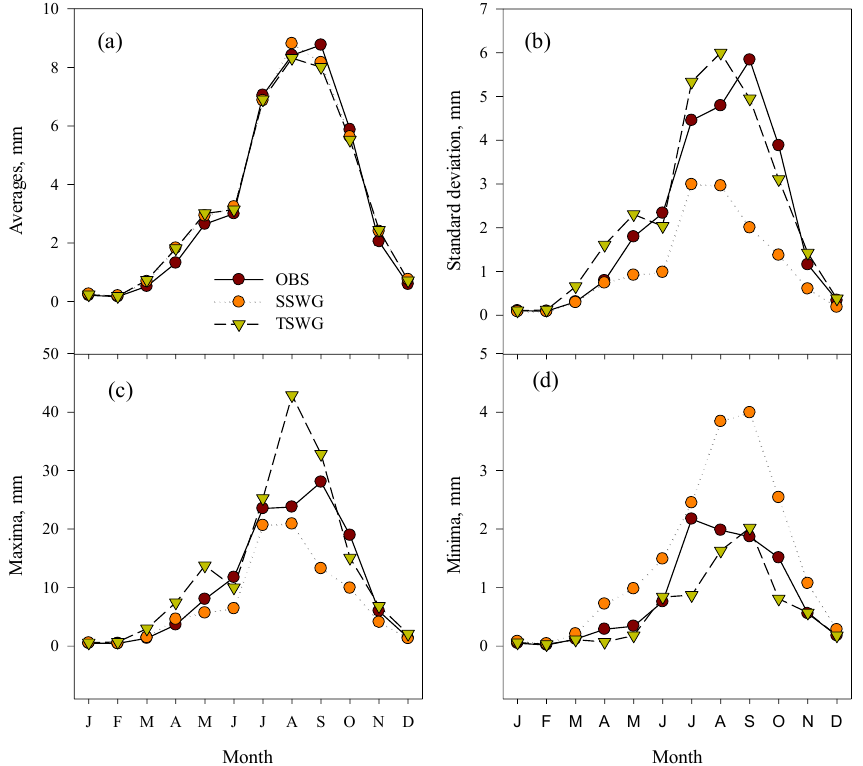
Figure 5. Statistics of observed (OBS) and simulated (by SSWG- and TSWG-generated climate) monthly streamflow. Observation period was 1961–1990 and the simulated runoff was from the 100-year climate generated from the statistical parameters from the observed climate. Table 2. Relative changes in annual mean climate between 1961–2005 and 2011–2040. P change, % T max change, ◦ C